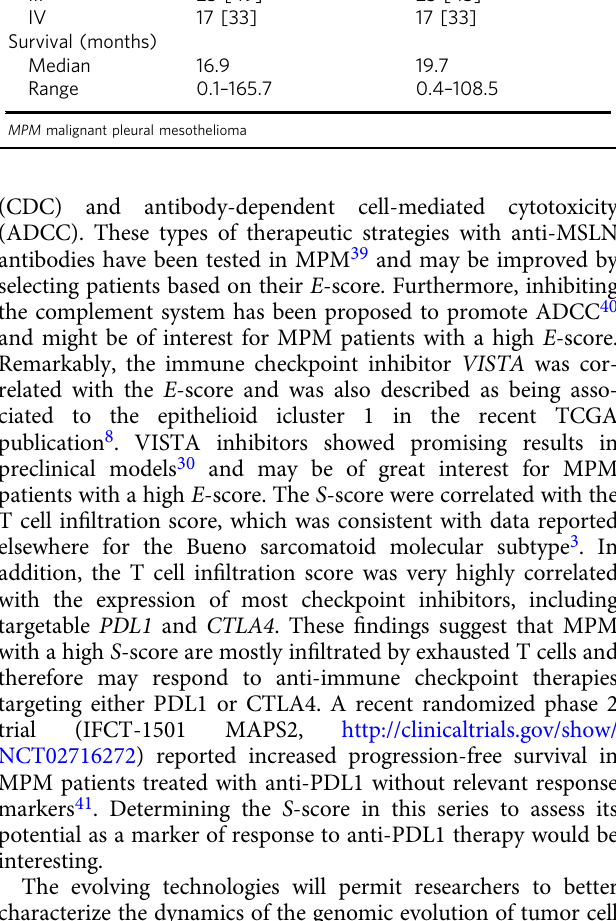
DNA and RNA extraction . For CIT exploration series, nucleic acids were extracted for 63 MPM tumor samples and 4 samples from normal pleura. Genomic DNA